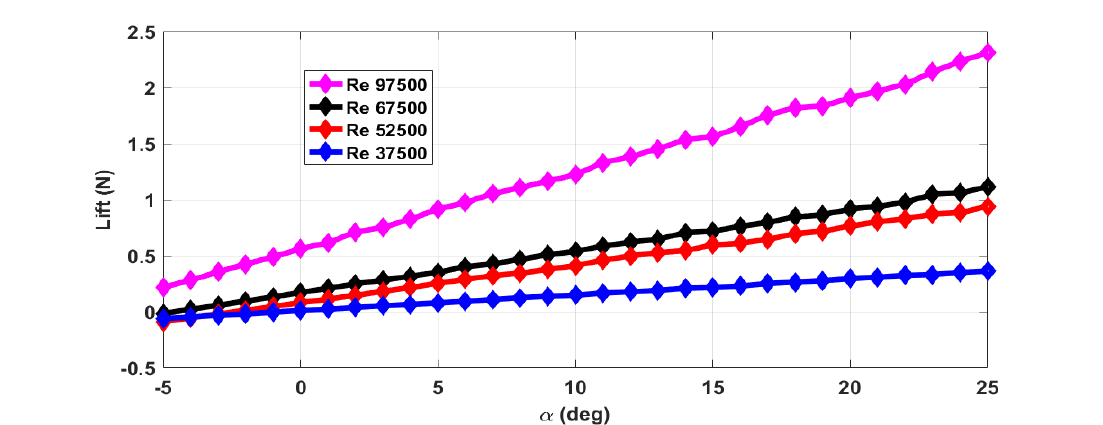
Figure 8. Lift force for zero elevator deflection and a propeller RPM of 12,000.